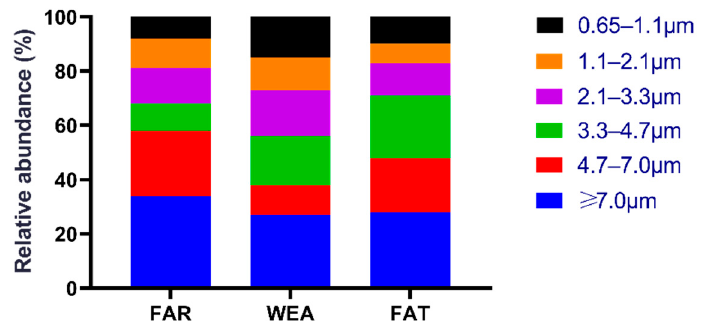
Figure 2. The distribution ratio of culturable airborne bacteria in different types of pig houses. FAR, farrowing houses; WEA, weaning houses; FAT, fattening